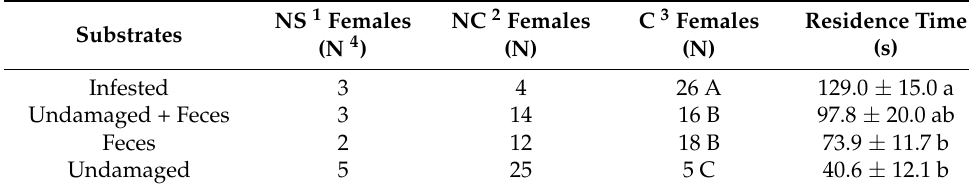
Table 1. Resident times (Mean ± SE) of T. elegans females in no-choice trials. Capital letters indicate significant differences among the numbers of choosing females ( χ 2 test, p < 0.05). Letters indicate significant differences among the times spent on the substrates (Kruskal–Wallis H test; p < 0.05). Residence Time NS 1 Females NC 2 Females Substrates (s) (N 4 ) (N) (N) Infested 3 Undamaged +